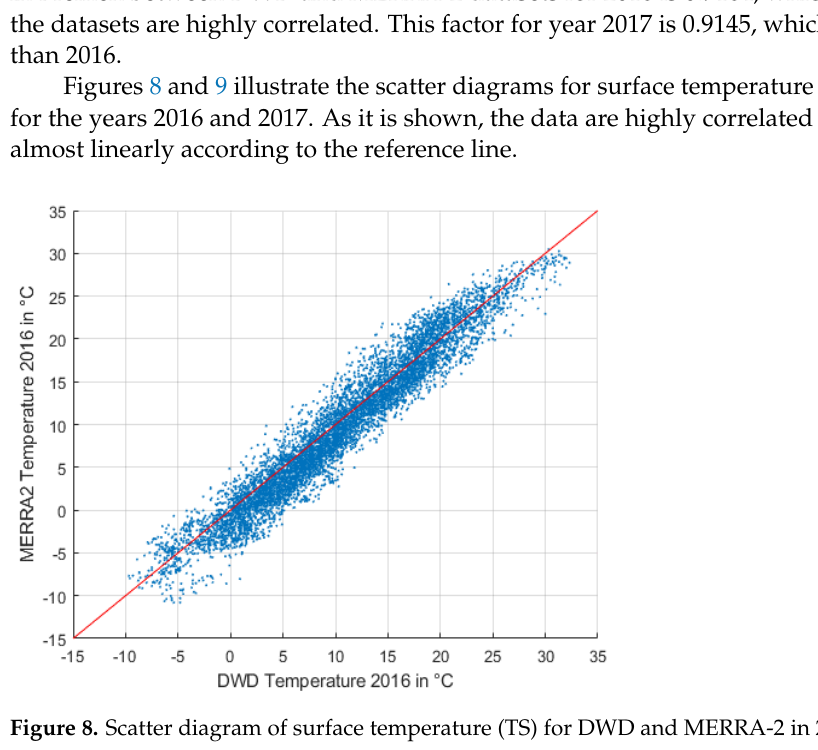
Figure 7. Scatter diagram of global irradiance (GI) for DWD and MERRA-2 in 2017 in Bremen.